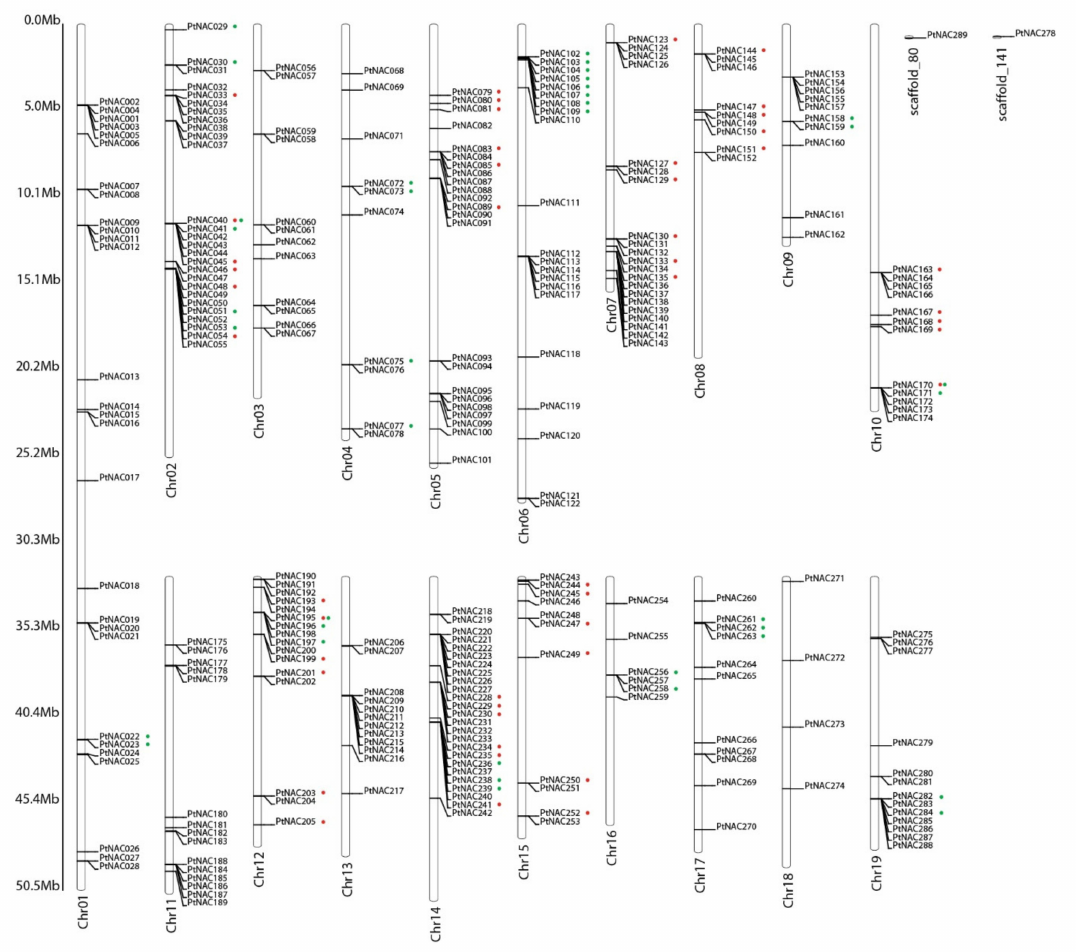
Figure 2. Chromosome locations of Populus NAC genes. The 287 NAC genes are mapped to the 19 LGs (Linkage-Groups) and the other two genes reside on sca ff old_80 and sca ff old_141. Whole-genome wide or segmental duplicated genes are labelled with red colour dots. The green dots indicate the genes are involved in tandem duplicates. The scales represent the distance of